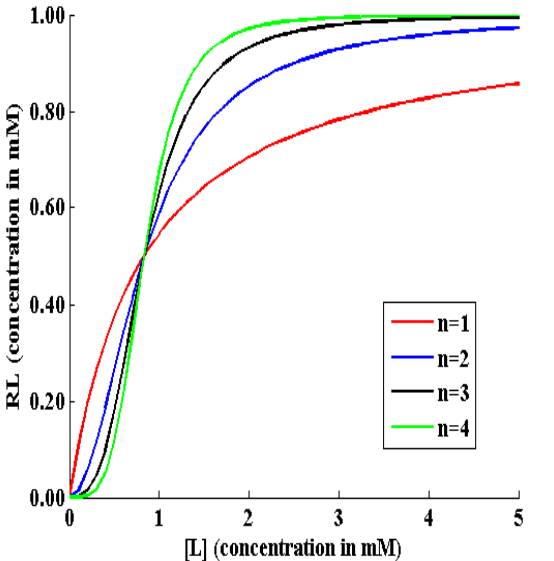
Fig. 4: Matlab Simulation results for Hill Equation as given in Eq. (2), illustrating the effect of changing Hill Coefficient n